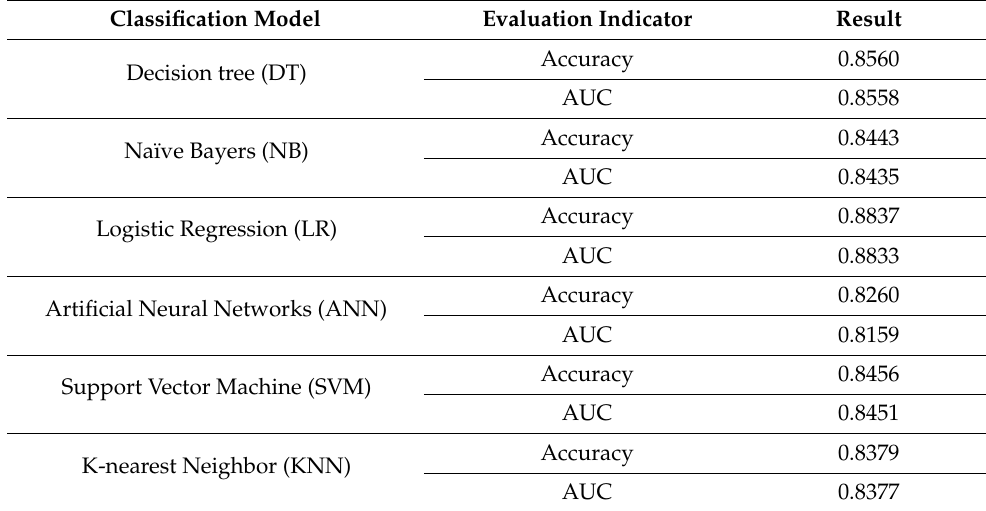
Table 3. Comparison of classification performance of classifiers.